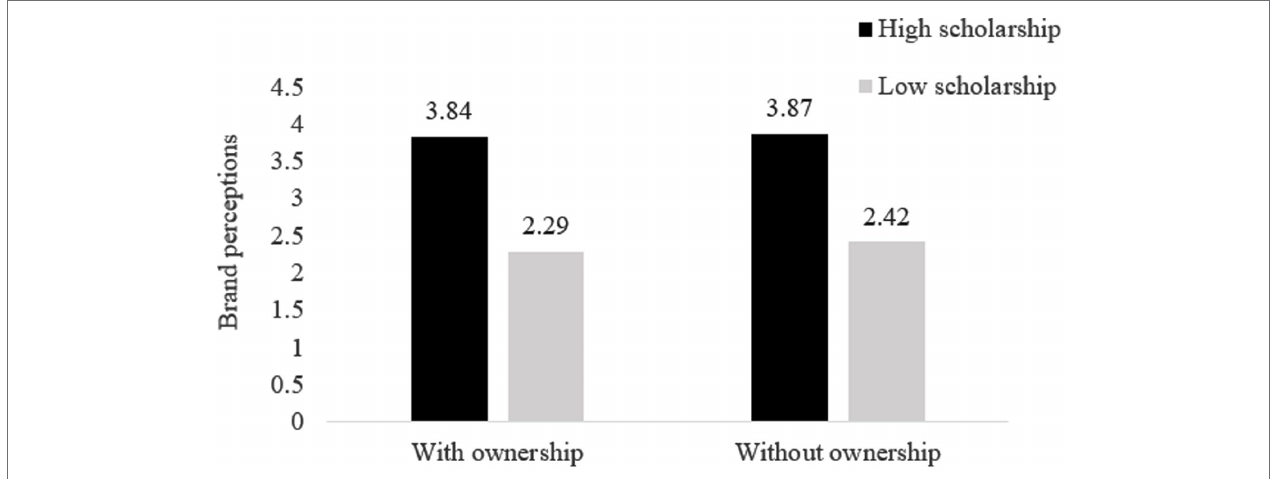
FIGURE 2 | The effect of scholarship policies and ownership levels on brand perceptions (Study